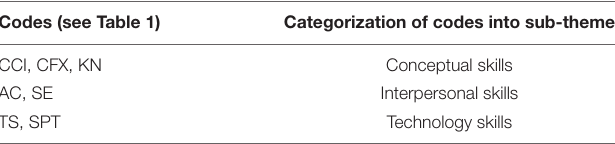
TABLE 2 | Categorizing codes from semi-structured interviews into three sub-themes. Codes (see Table 1) Categorization of codes into